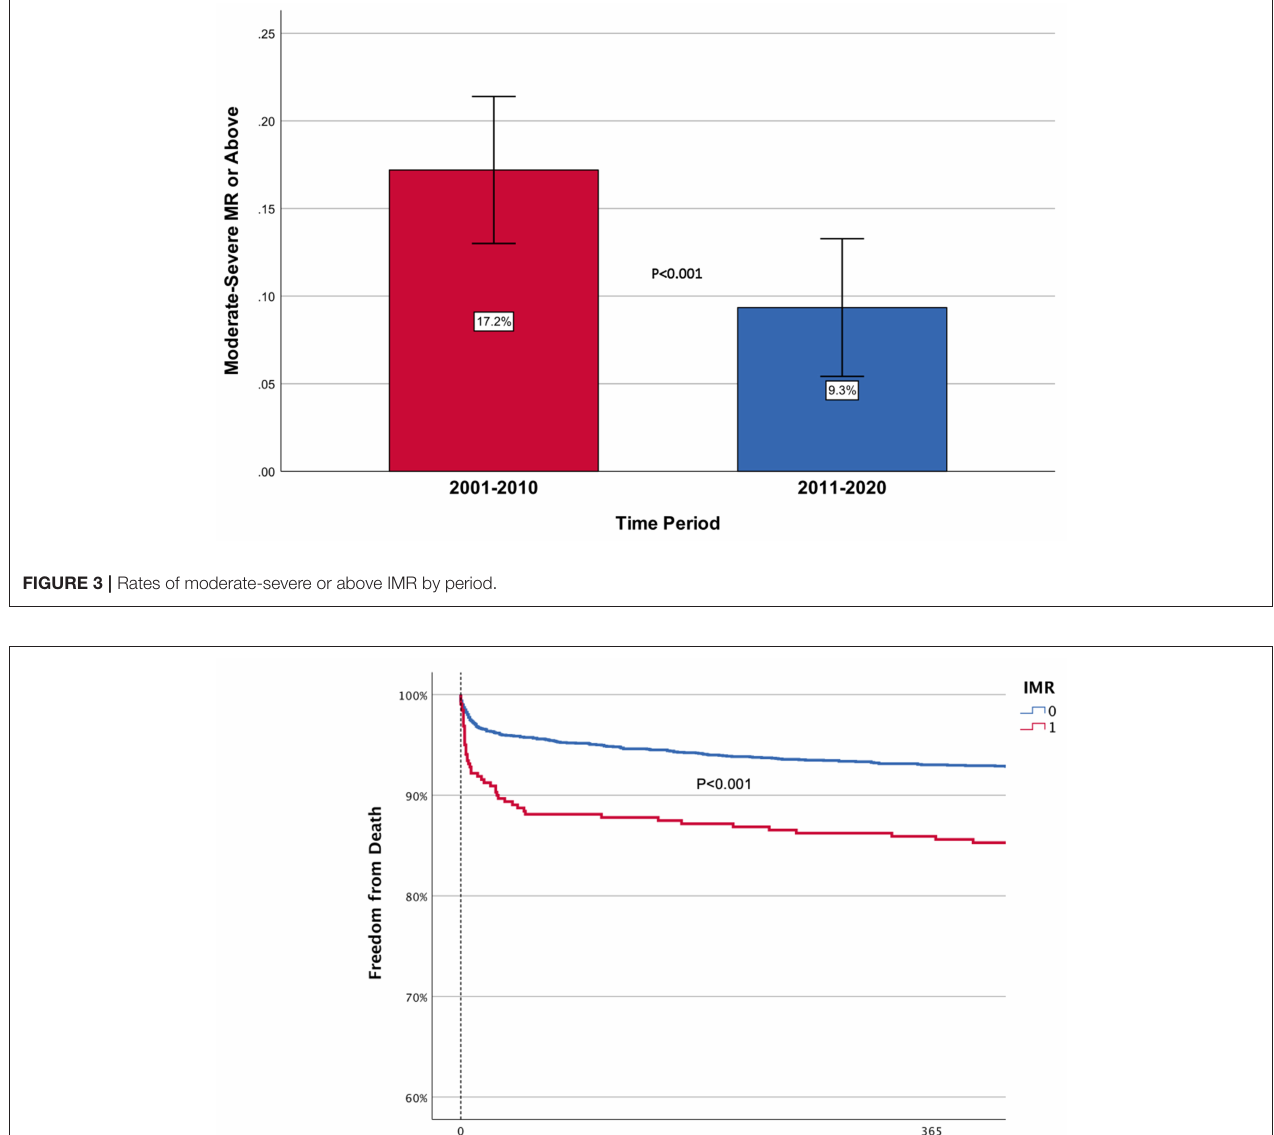
or above after 3 months was 17.9 and 28.7% after 1 and 2 years, respectively, vs. 10.7 and 17.9% for those without IMR ( p < 0.001 for